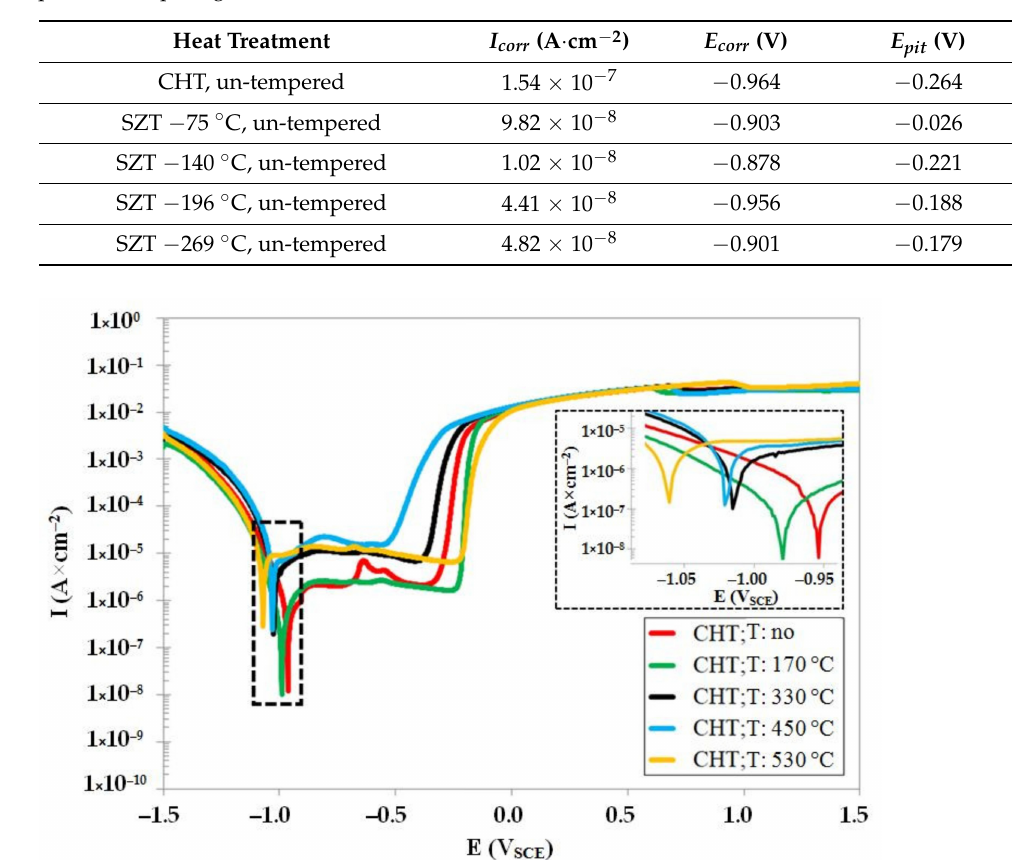
Table 3. Corrosion current, I corr , corrosion potential, E corr , and pitting potential, E pit , values acquired from corrosion tests in 3.5 mass % NaCl water solution, for CHT and different SZT specimens in the prior-to-tempering state.